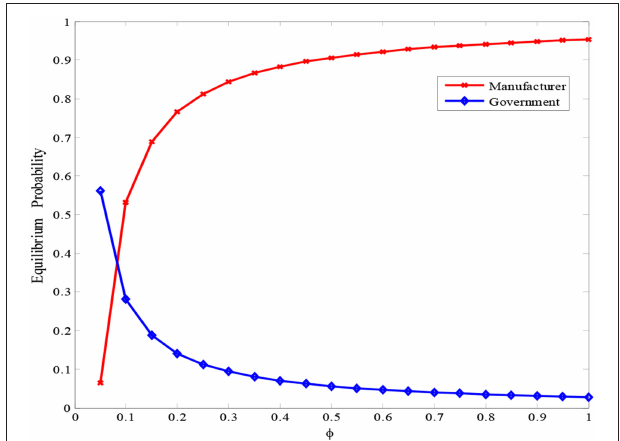
FIGURE 4 | Game members’ equilibrium probabilities as a function of ϕ .